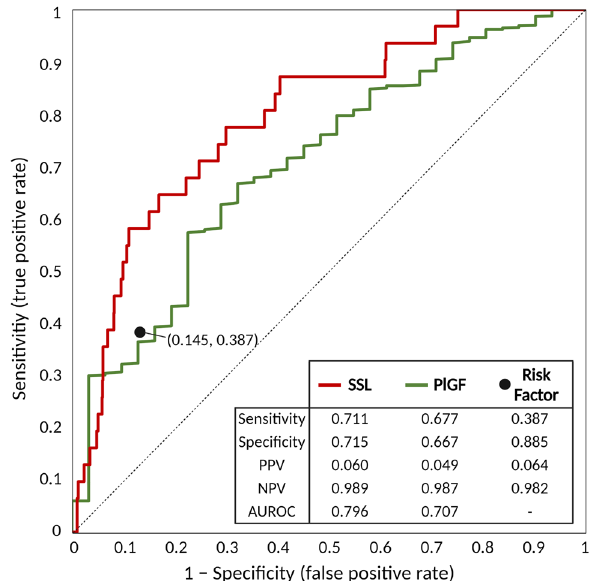
Figure 2. Receiver operating characteristic curve of proposed prediction model vs. placental growth factor (PlGF). Risk factors: conventional risk factors recommended by American College of Obstetricians and Gynecologists. AUROC the area under the ROC curve, NPV negative predicted value, PlGF placental growth factor, PPV positive predicted value, SSL semi-supervised learning.